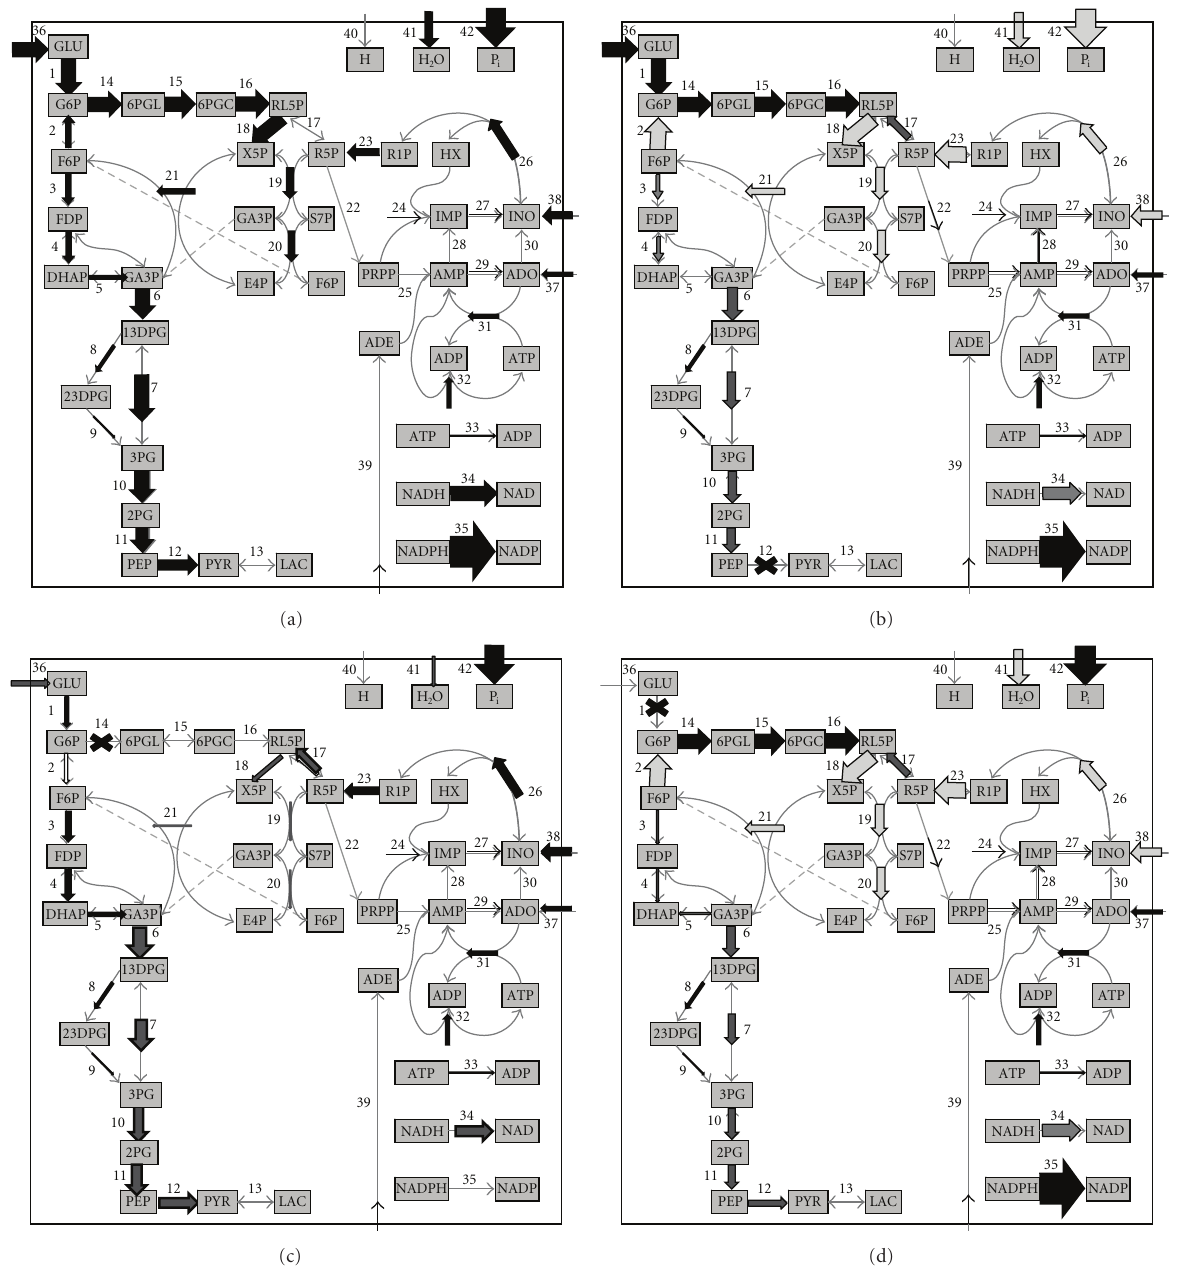
Figure 5: Maps of fluxes in the healthy hRBC (a) and flux rerouting in three full enzymopathies: PK (b), G6PDH (c) and HK (d). The thick arrows are dark grey if the reaction rates diminish with respect to the healthy cell, light grey if they are higher, black if they remains the same. The widths of the arrows are proportional to the mean value of the corresponding